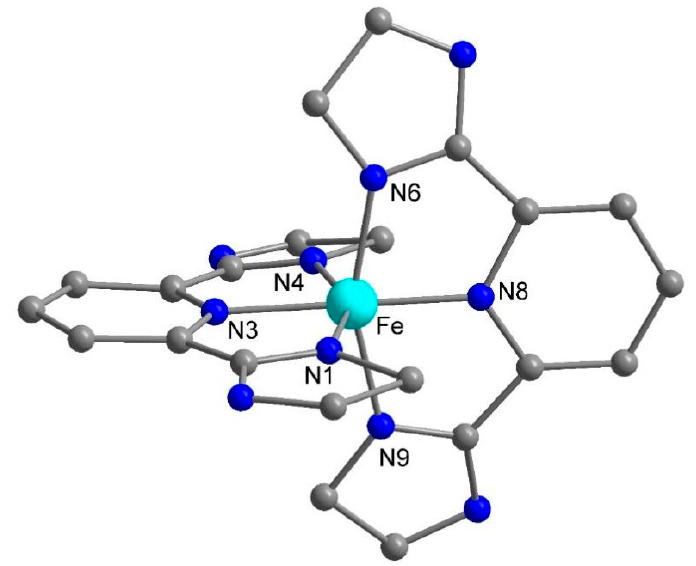
Figure 2. General view of the structure of the coordination core obtained by means of EXAFS spectra